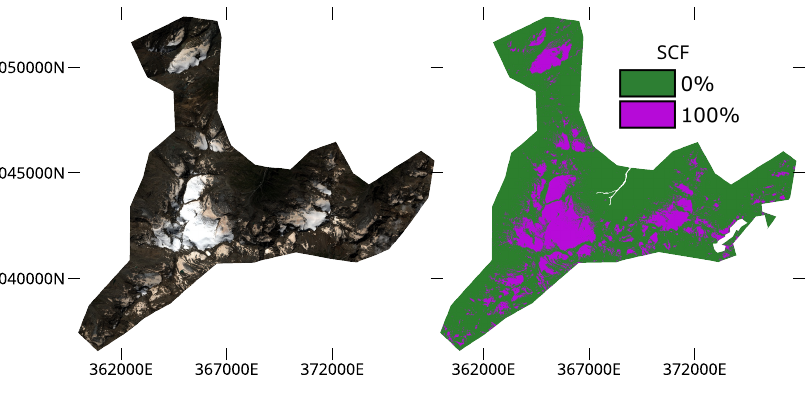
Figure A2. ( Left ): WorldView-2 true colour composite taken on 27 August 2020 (reference № 2 in Table A2). ( Right ): Binary snow classification of the left-side image.